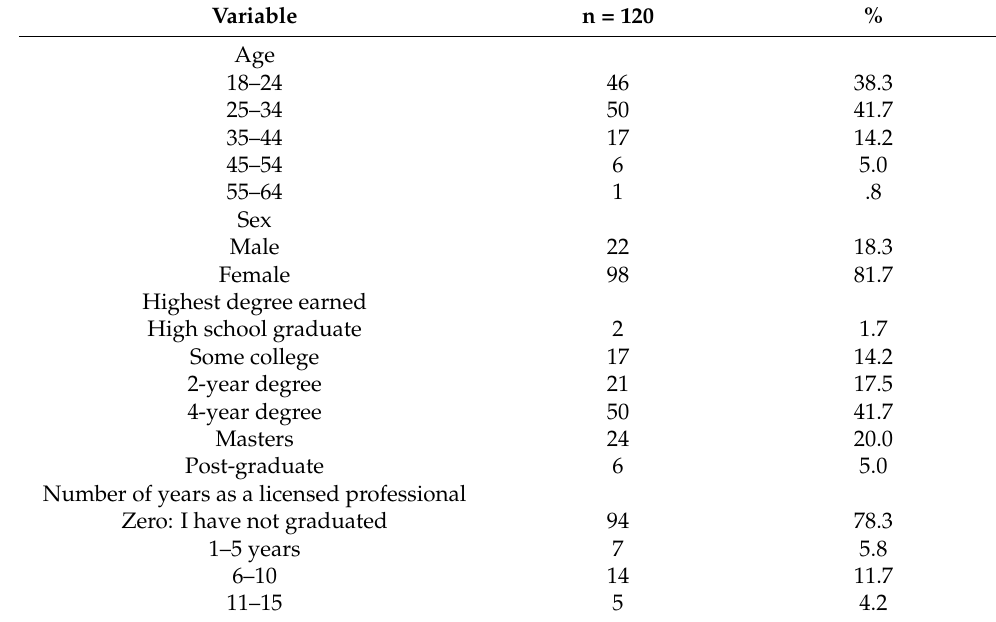
Table 1. Demographic Characteristics of Respondents (n =